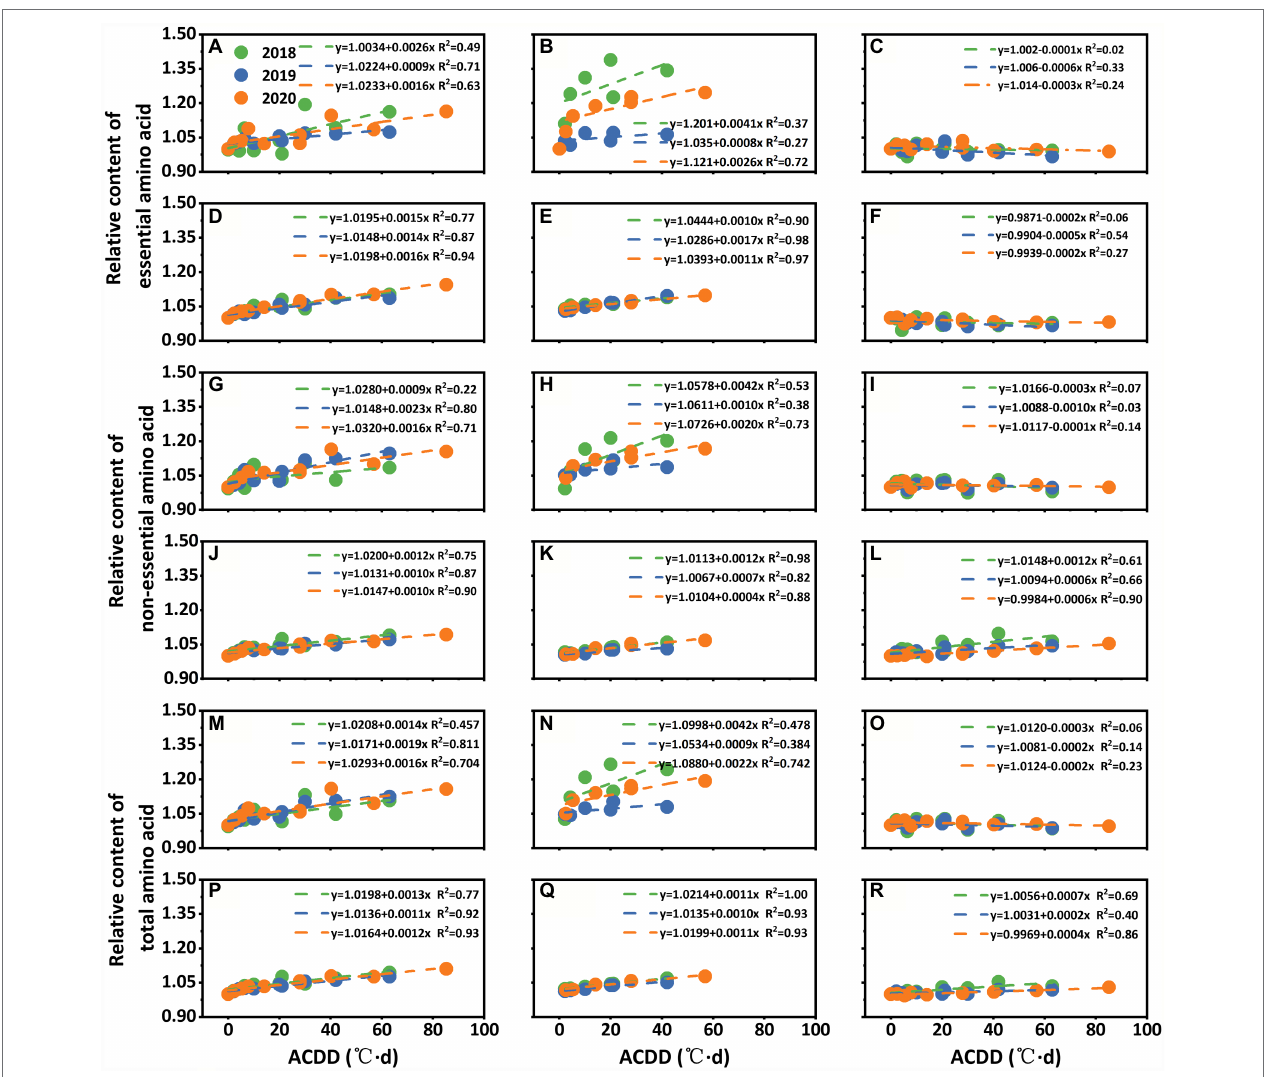
FIGURE 4 | Relationship between low-temperature stress at early flowering (A,D,G,J,M,P) , peak flowering (B,E,H,K,N,Q) , and grain filling (C,F,I,L,O,R) stages and the relative contents of amino acids in Huaidao 5 (A–C,G–I,M–O) and Nanjing 46 (D–F,J–L,P–R) at maturity. ACDD: accumulated cold degree days. Three different colors indicate results from three growing seasons in 2018–2020. (A–F) present the relative content of essential amino acids. (G–L) present the relative content of non-essential amino acids. (M–R) present the relative content of total amino